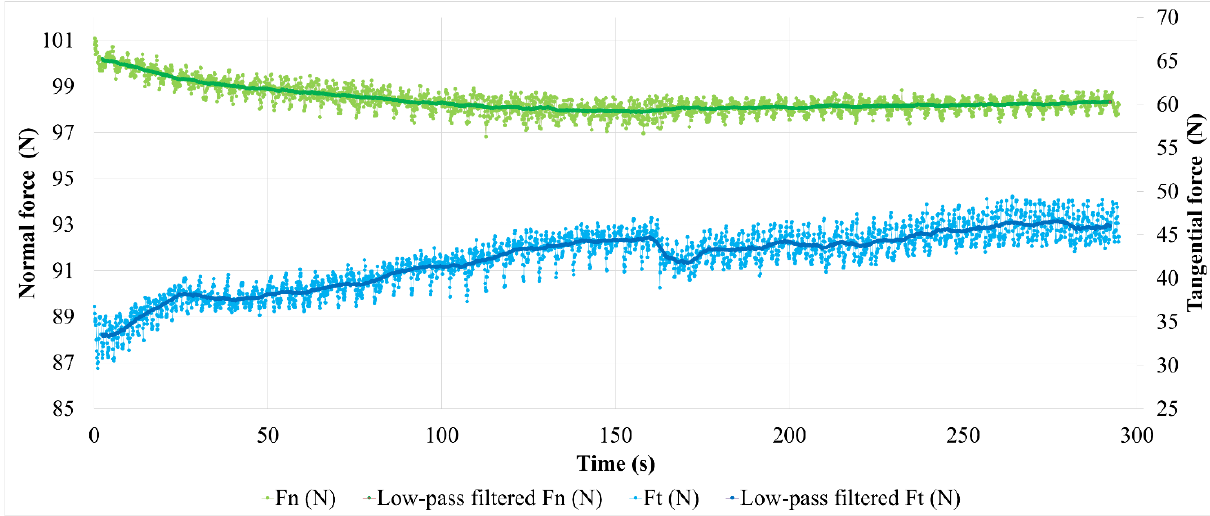
Figure 14. Evolution of contact forces for material M2.